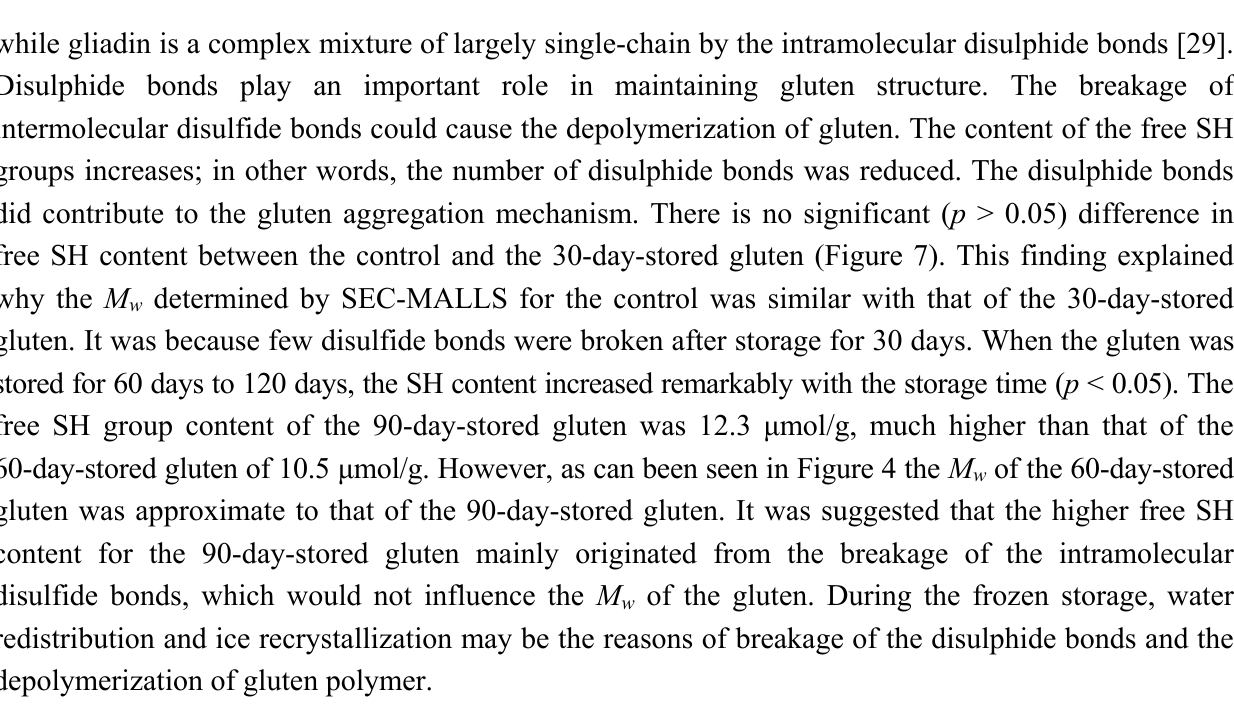
Figure 7. Effect of frozen storage time on the SH content of the wheat